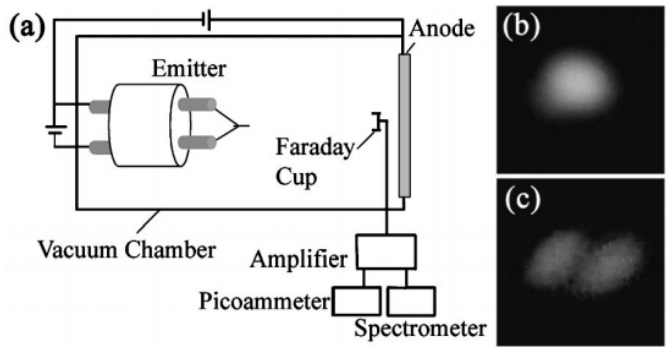
Figure 12. ( a ) The measurement setup for angular intensity of individual ZnO nanowire. ( b , c ) Typ- ical field-emission pattern of the nanowire. Reproduced from [64], with the permission of AIP Publishing, 2003.